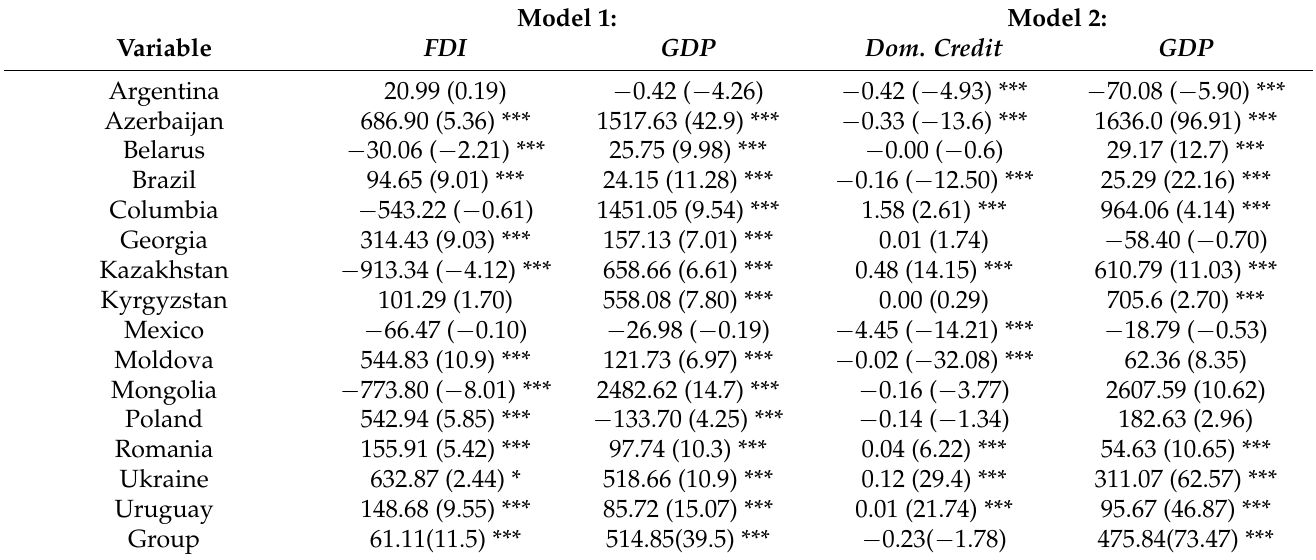
Table 5. Panel FMOLS estimation.